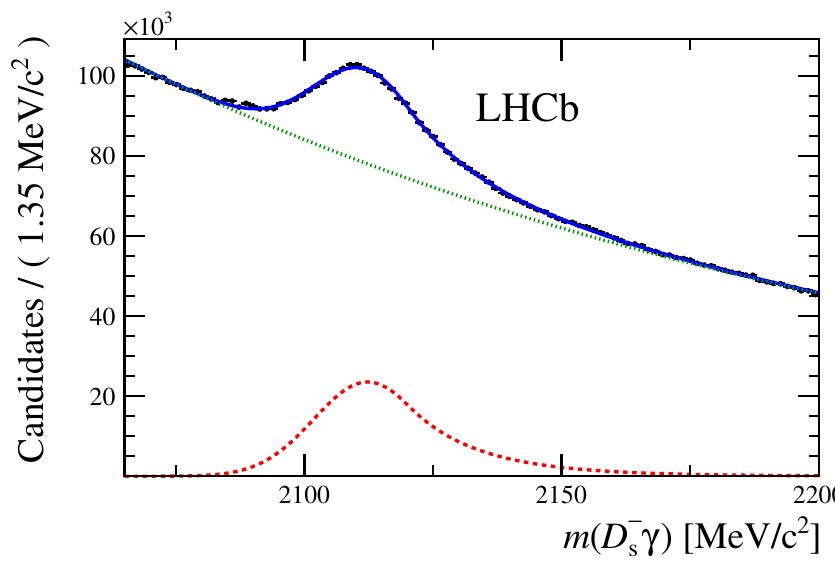
Figure 2 . Distribution of the reconstructed D − γ mass, m ( D − γ ) , with the fit overlaid. The fit is s s performed constraining the D − mass to the world-average value [16]. The signal and background s components are shown separately with dashed red and dotted green lines, respectively.